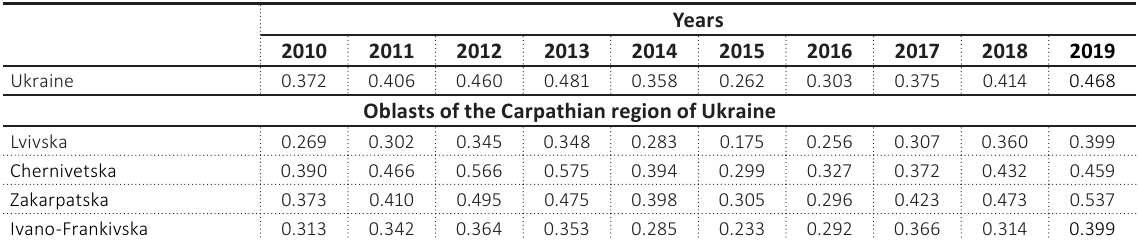
Source: Compiled based on the data in Table 3 and Figure